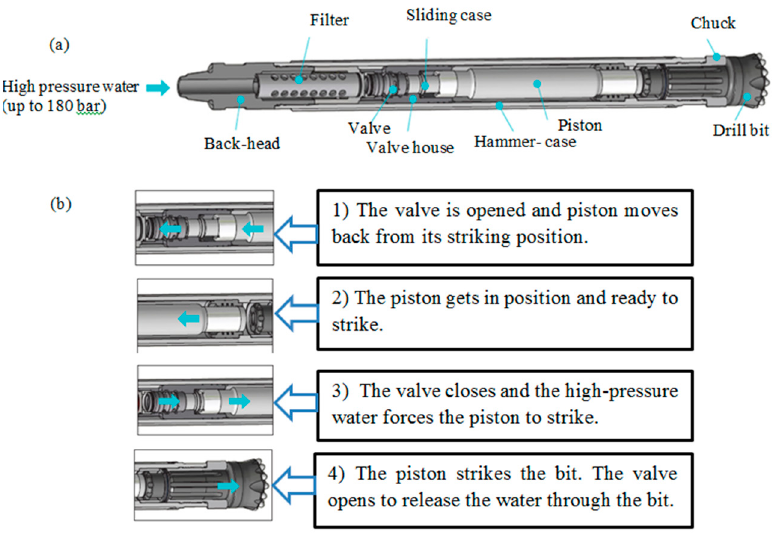
Figure 3. ( a ) Components; and ( b ) function of the Wassara ITH hammer [30].